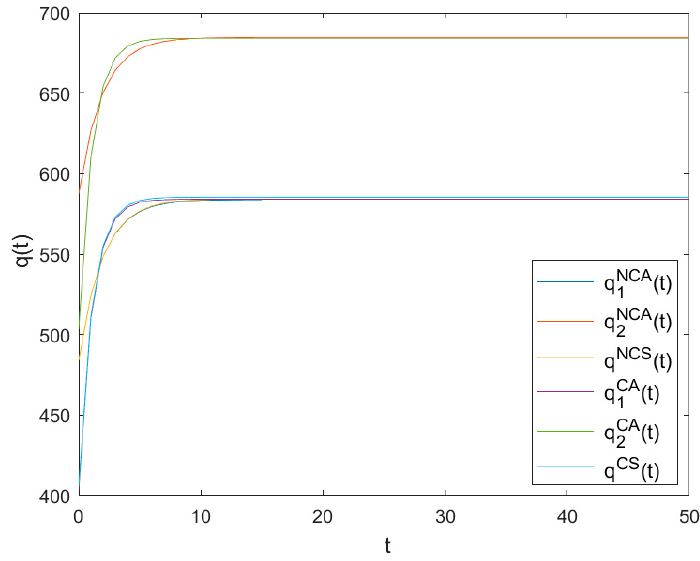
Figure 2. Evolutions of the optimal production levels.